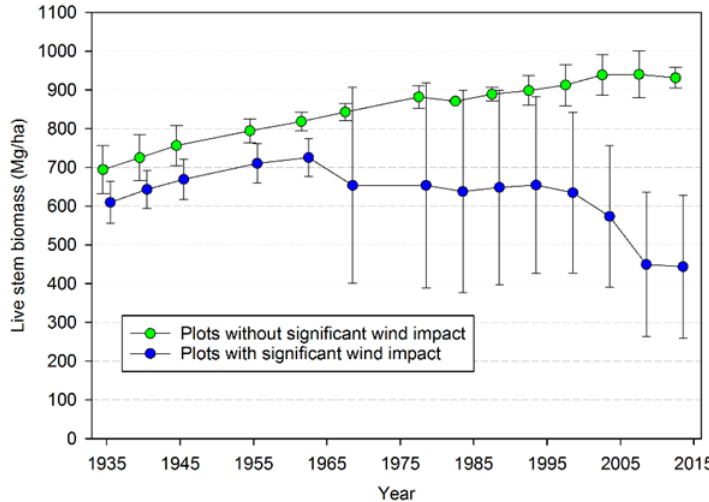
Figure 6. Average live biomass (with standard deviations) in plots not significantly impacted by wind ( n = 3, green circles) vs those significantly impacted by wind ( n = 7, blue circles).